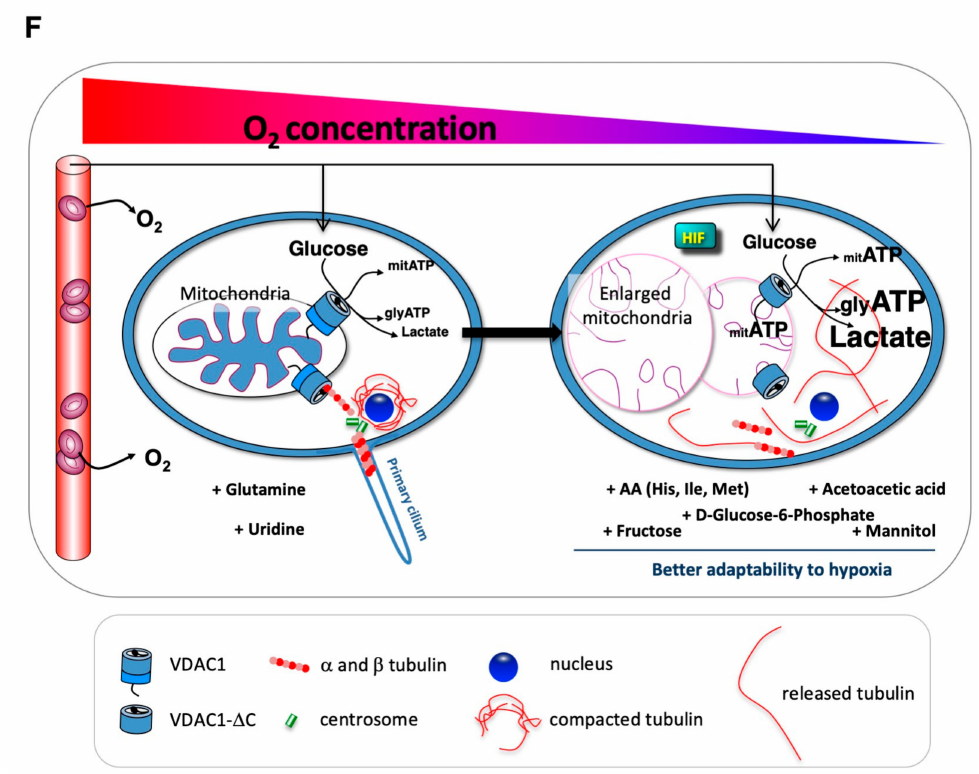
Figure 6. VDAC1- ∆ C has a direct impact on metabolism in normoxia. ( A ) Respiratory control of Cleavable#2, UnCleavable#2 and Truncated-VDAC1#4. OCR was measured in real time with the XF24 analyzer in Nx. The mean ± SEM is representative of at least three independent experiments carried out in quadruplicate. ( B ) ECAR in Nx of Cleavable#2, UnCleavable#2 and Truncated-VDAC1#4 was evaluated with with the XF24 analyzer. The mean ± SEM is representative of at least three independent experiments carried out in quadruplicate. ( C ) Heatmap showing the 7 substrates that were communly metabolized by Cleavable#2, UnCleavable#2, and Truncated-VDAC1#4 in normoxia. The color key scale for each substrate is based on dye reduction quantified by Omnilog units. A yellow color indicates strong positive substrate metabolization, a green color moderate metabolization and a blue color indicates no substrate metabolization. Data area under the curve (AUC) < 500 have been excluded. ( D ) Venn diagram comparing metabolic phenotyping of Cleavable#2 in hypoxia, UnCleavable#2 in hypoxia and Truncated-VDAC1#4 in normoxia. Data AUC > 500. ( E ) Respiratory control of Truncated-VDAC1#4 in the presence of Vismodegib (50 µ M). OCR was measured in real time with the XF24 analyzer normoxia (Nx). Cells were deprived of glucose for 1 h, then glucose (G), oligomycin (O), FCCP (F), and Rotenone + Antimycin A (R / A) were injected at the indicated times. ( F ) Graphical model. * indicates p < 0.05 and ** indicates p <